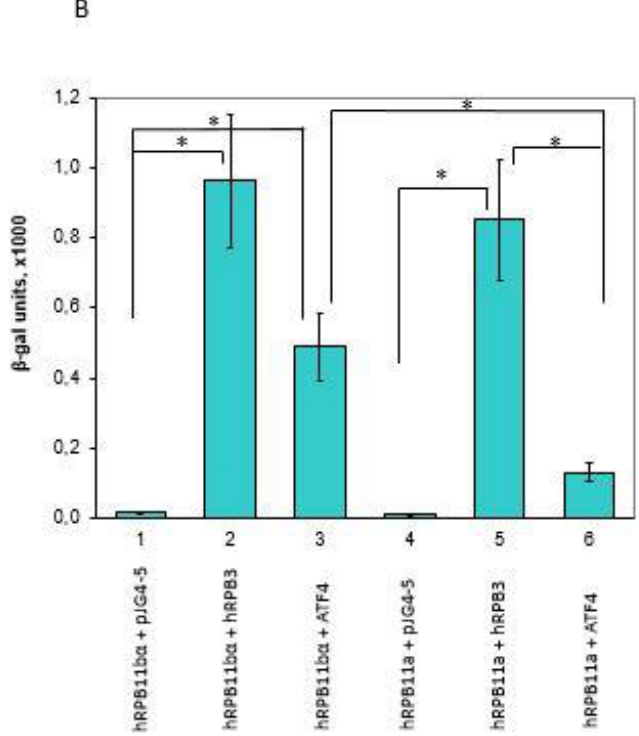
Figure 1. ( A ) Two-hybrid analysis of hRPB11bα interactions. Serial dilutions of SKY191 yeast cells containing the indicated plasmid combinations were spotted onto SD-Gal/Raff plates lacking triptophan, histidine, and uracil (-WHU) to verify that yeast contains both the bait and prey plasmids (left panel) or triptophan, histidine, uracil, and leucine (-WHUL) for demonstration of the interaction between the bait and prey (central panel). Three independent clones of each of the SKY191 transformants were spotted onto X-gal containing plate (right panel) for confirmation of positive interactions (the picture was made on the red background for the better visualization of both negative and positive clones). In comparison, the yeast strains containing an empty vector pJG4-5 or library-derived plasmid encoding C-terminal part of hRPB3 were used as negative or positive controls, respectively. ( B ) Assessment of interaction of hRPB11bα and ATF4. SKY191 yeast cells were cotransformed with the indicated constructs and assayed for β-galactosidase activity in the liquid medium by means of the Miller method [31]. The pairs of hRPB11bα–hRPB3 and hRPB11a–hRPB3 interacting proteins were taken as a positive control. Error bars: Standard deviation; statistical analysis: * p < 0.05 for all measurements.